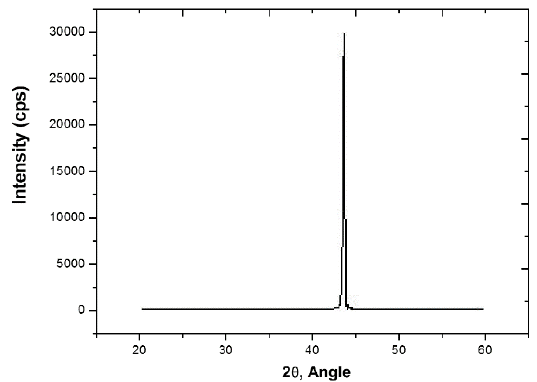
Figure 1. XRD pattern. Diamond crystals as received from the manufacturer.